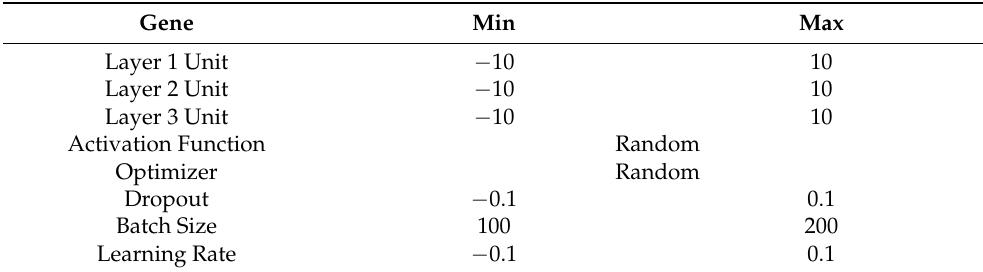
Table 3. Mutation